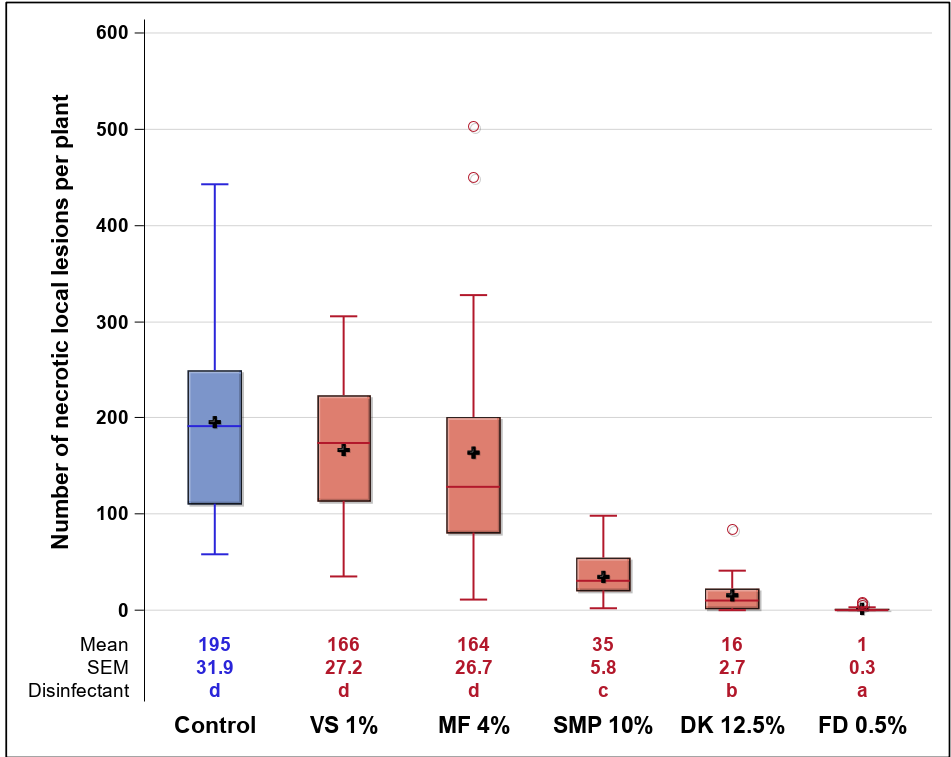
Figure 3. Evaluation of the efficiency of different disinfectants in inactivating Tomato brown rugose fruit virus on natural rubber at a contact time of 30 s. by counting the number of necrotic local lesions on mechanically inoculated leaf halves of N. tabacum cv. Xanthi NN. Observations are shown in a boxplot, cross inside = mean value. ‘SEM’ = Standard Error of the Mean Letters based on pairwise treatment comparisons using a generalized linear mixed model analysis of count data (alpha = 0.05, with Bonferroni correction). n = 24. ‘VS’ = Virkon S, ‘MF’ = Menno Florades, ‘SMP’ = Skim milk powder, ‘DK’ = DanKlorix, ‘FD’ = Floradix.